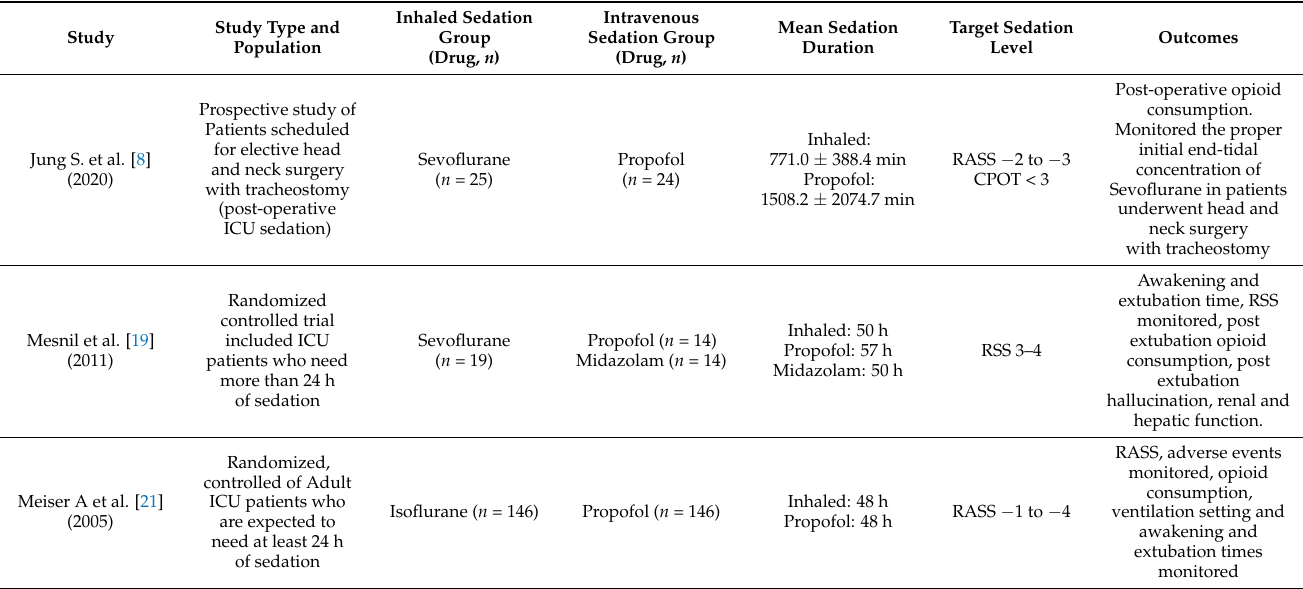
Table 2. Published trials in a chronological order demonstrating the analgesic drugs sparing effect of inhaled sedation compared to intravenous